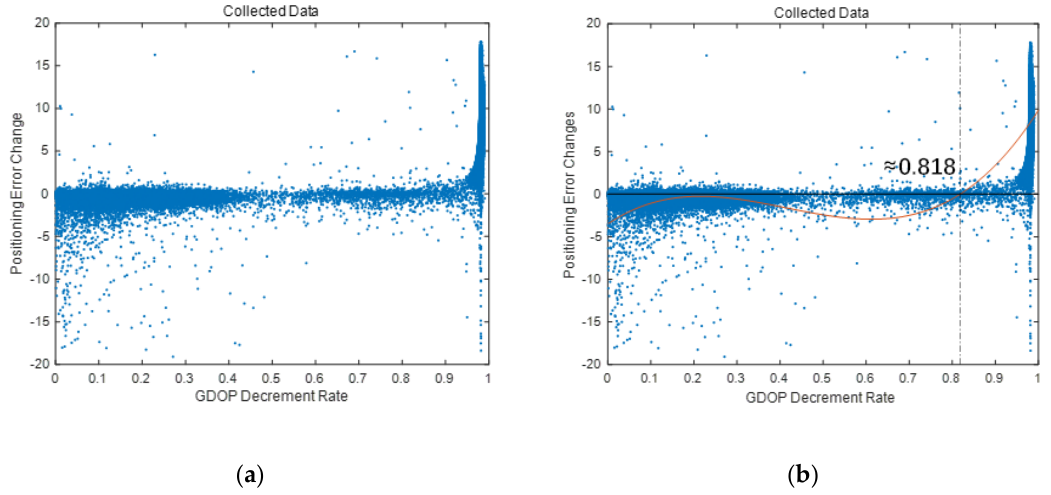
Figure 4. The distribution of collected GDOP decrement rates and positioning error changes in simulation. ( a ) the distribution of collected data. ( b ) the linear regression result.